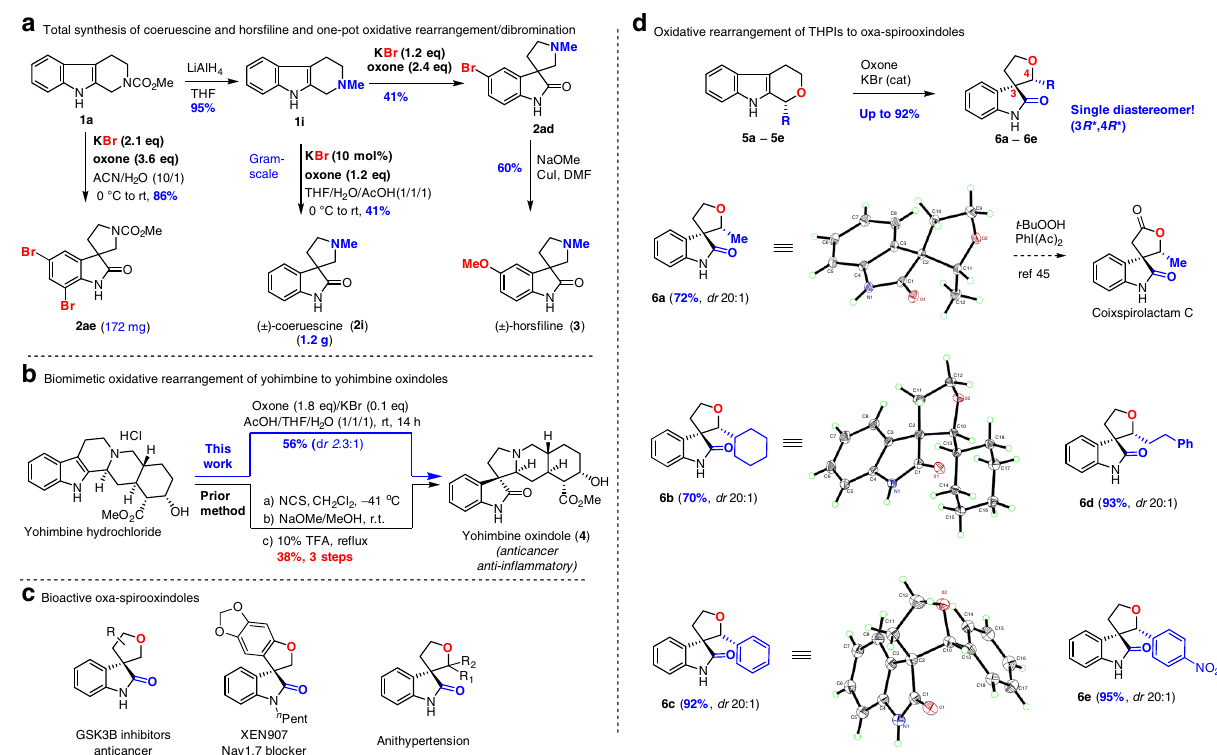
Fig. 3 Synthetic utility of our halide catalysis for the oxidative rearrangement. a Total synthesis of (±)-coerusecine and (±)-hors fi line and one-pot bromination of spirooxindole. b Oxidative rearrangement of Yohimbine to β -Yohimbine oxindole. c Bioactive molecules bearing oxa-spirooxindole. d Oxone-KBr oxidative rearrangement of tetrahydropyrano[2,3-b]indoles (THPIs) to